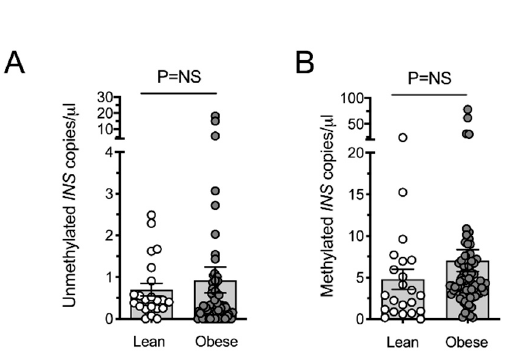
Figure 1. Circulating unmethylated and methylated INS DNA in lean and obese adults. DNA was isolated from serum of subjects and bisulfite converted as described previously [38]. Primers and dual-fluorescent probes for interrogating methylation at CpG position − 69 at the human INS gene using droplet digital PCR were described previously [26,34]. Values were normalized for DNA recovery, and back-calculated to the volute of serum used in the DNA isolation ( A ) Circulating unmethylated INS DNA; ( B ) circulated methylated INS DNA. A Kruskal–Wallis (non-parametric) test was employed followed by a Dunnett’s post-test (to compare values to Lean controls). Statistical significance was assumed at p < 0.05. Data are presented as mean ± SEM.